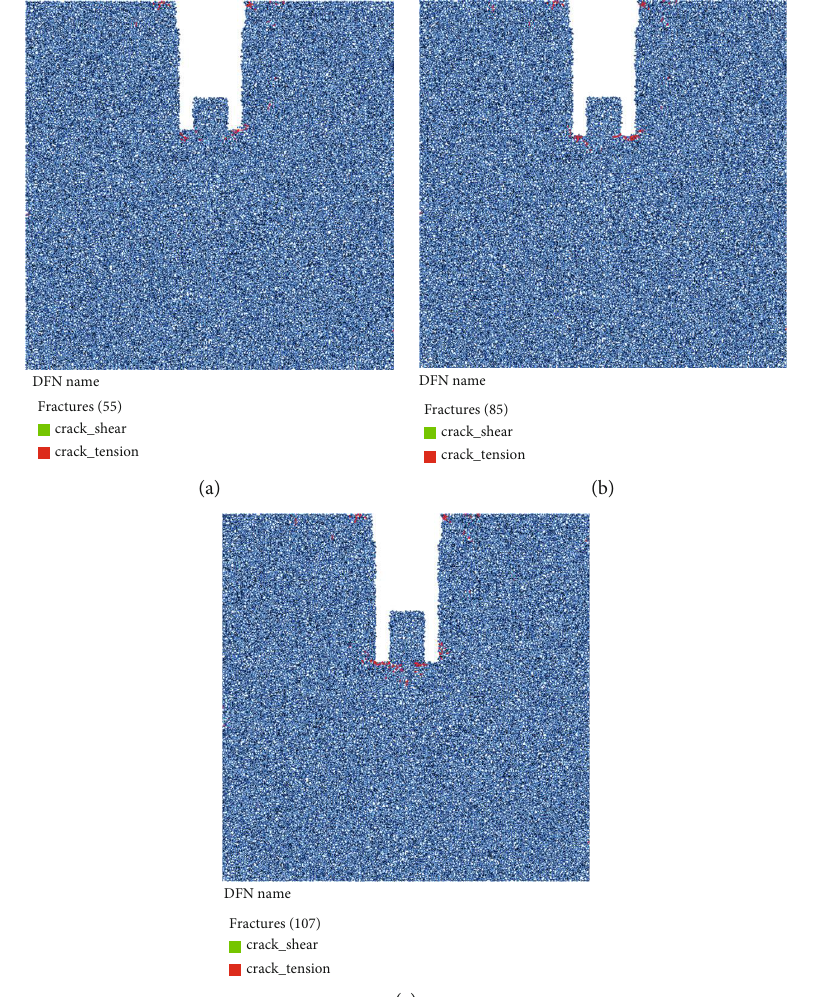
Figure 10: Typical crack distribution diagrams of the model under di ff erent drilling depths. (a) h = 3 : 40cm . (b) h = 3 : 80 cm . (c) h = 4 : 00 cm